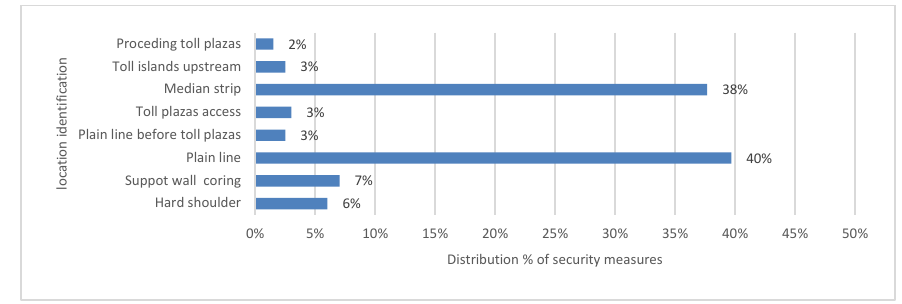
Figure 6. Safety measures by location